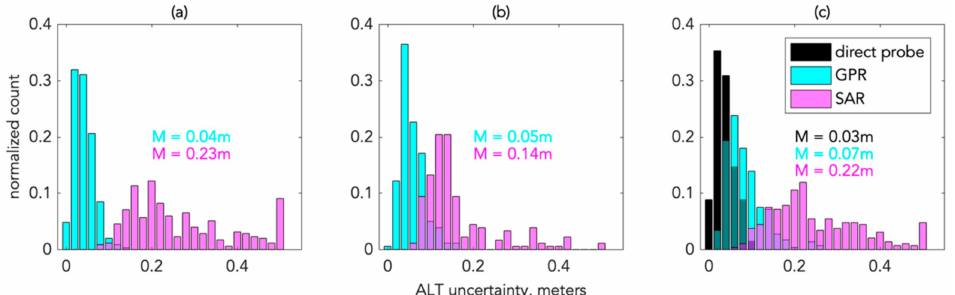
Figure 6. Frequency distributions of ALT uncertainty for the ( a ) BRW, ( b ) TOO, and ( c ) YKD swaths. Median values (M) are reported for each frequency